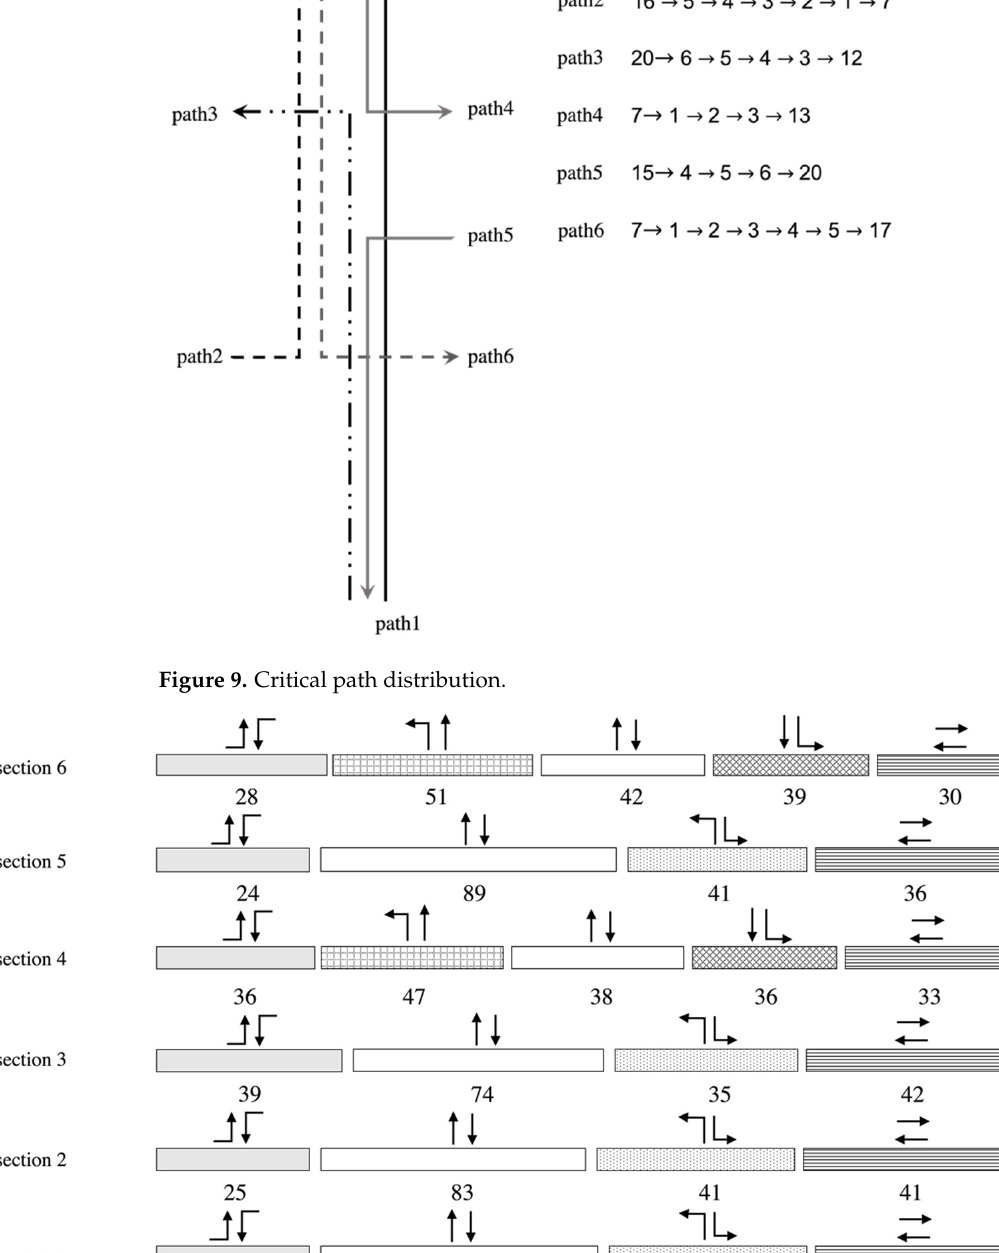
Figure 10. Intersection signal scheme.